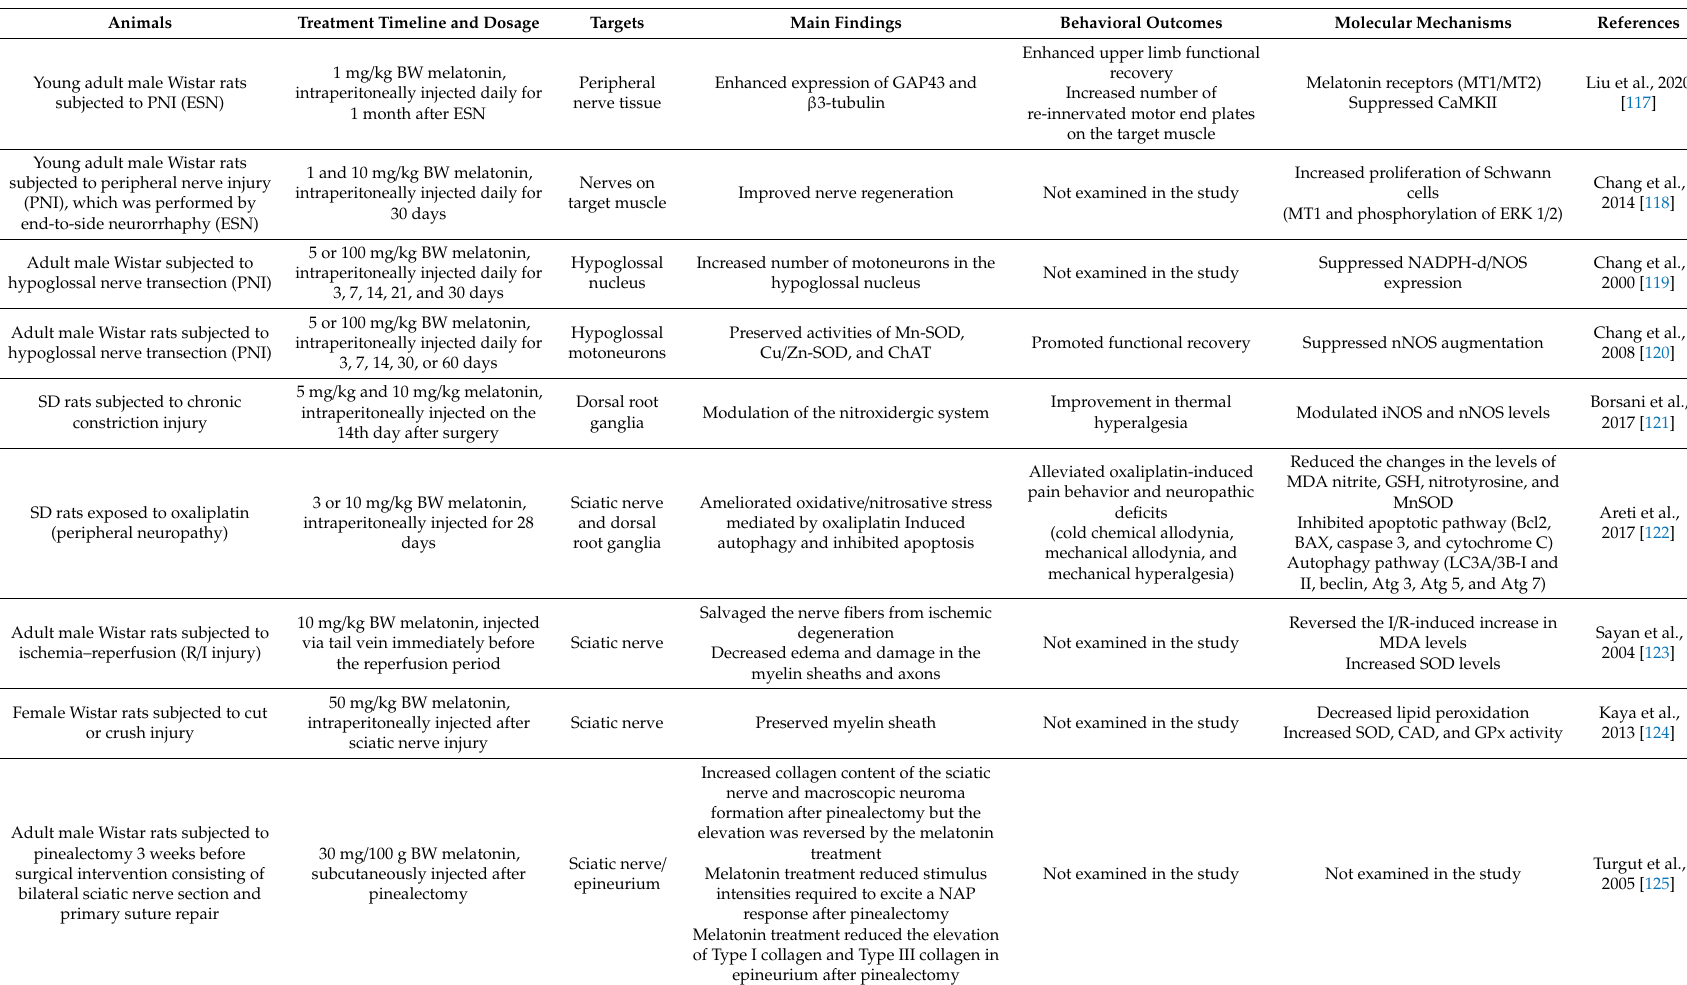
Table 14. Table showing the main findings regarding the e ff ects of melatonin on peripheral nerve impairment and the respective molecular mechanisms in the in vivo